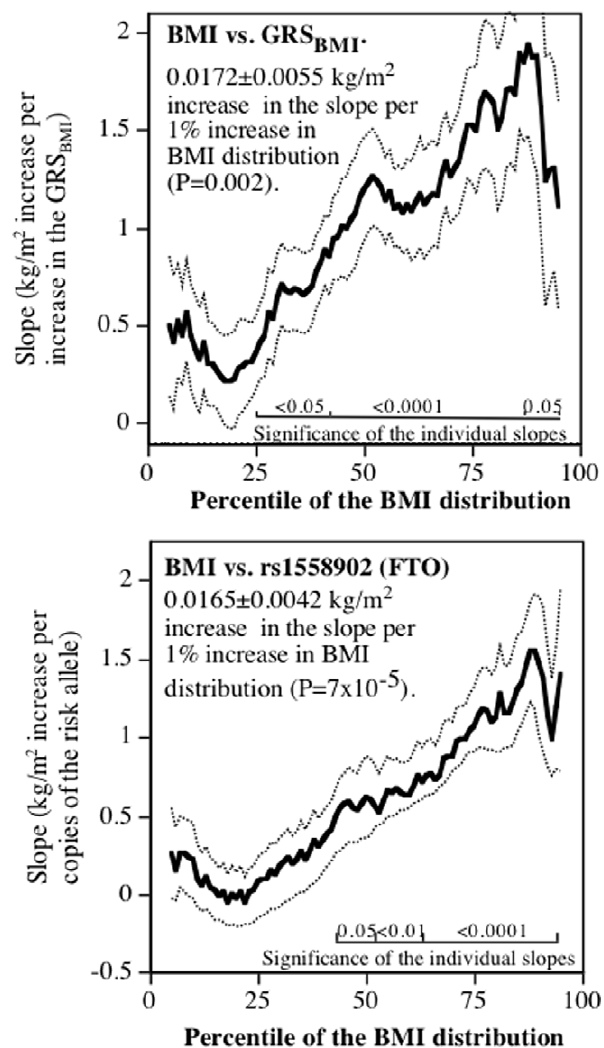
Figure 4. Slopes for BMI versus GRS BMI and rs155890 (FTO gene, Y-axis) by the percentile of the BMI distribution (X-axis). Lighter lines designate 6 one standard error.